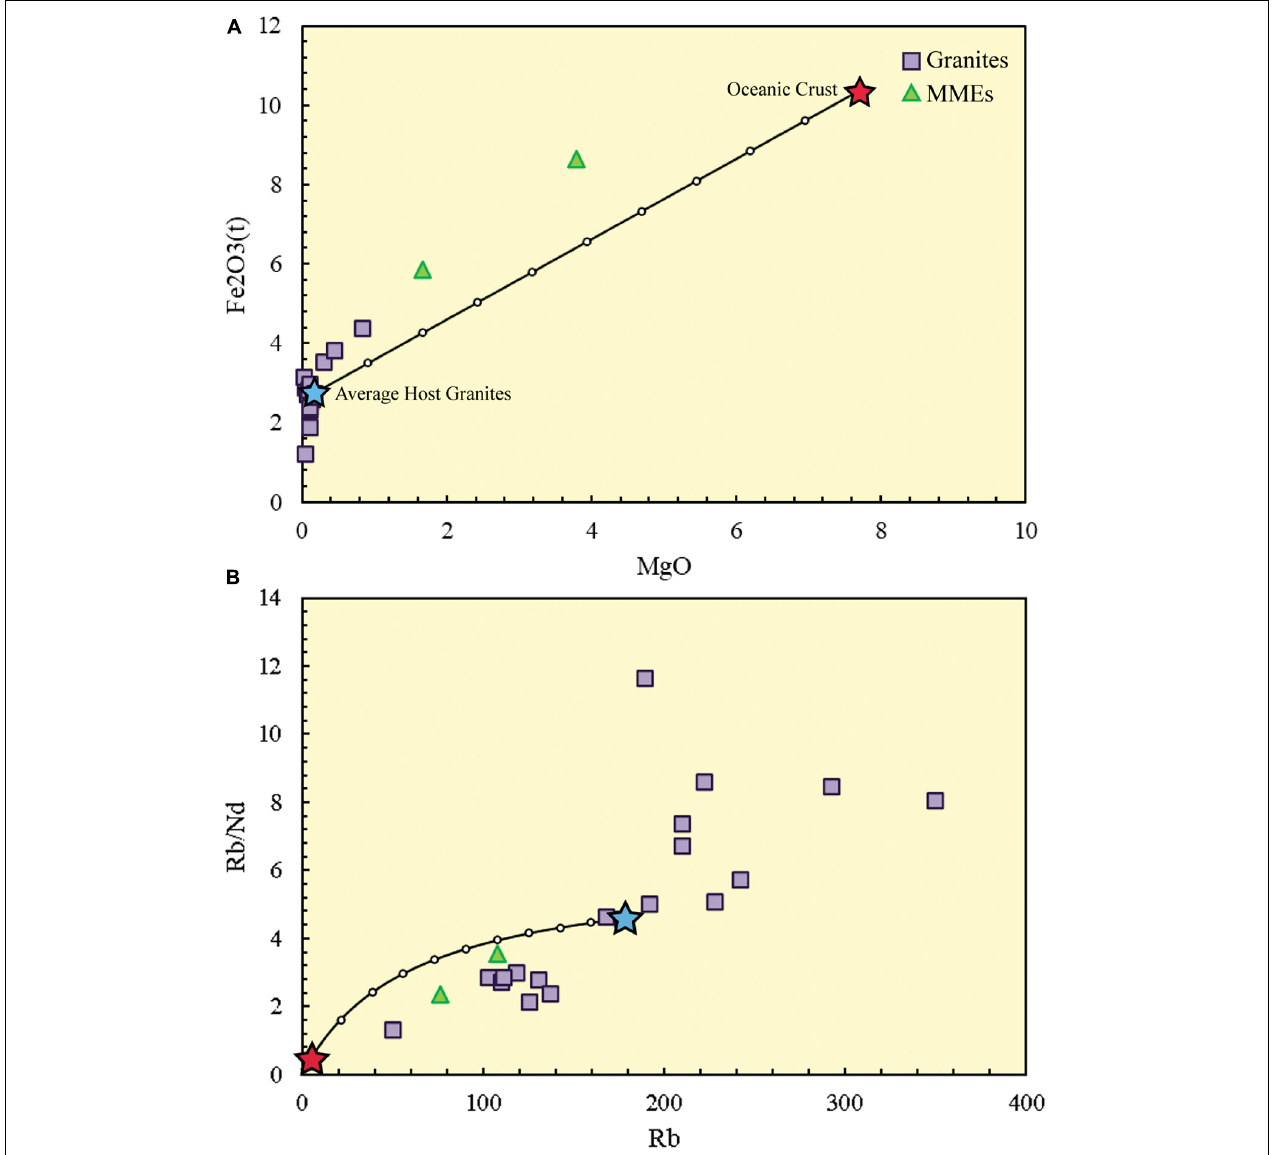
FIGURE 6 | Binary plots with magma mixing curves. (A) MgO versus Fe 2 O 3 (Zorpi et al., 1989); (B) Rb/Nd-Rb (Schiano et al., 2010). The estimation shows that ∼ 40-70% felsic magma mixed with mafic